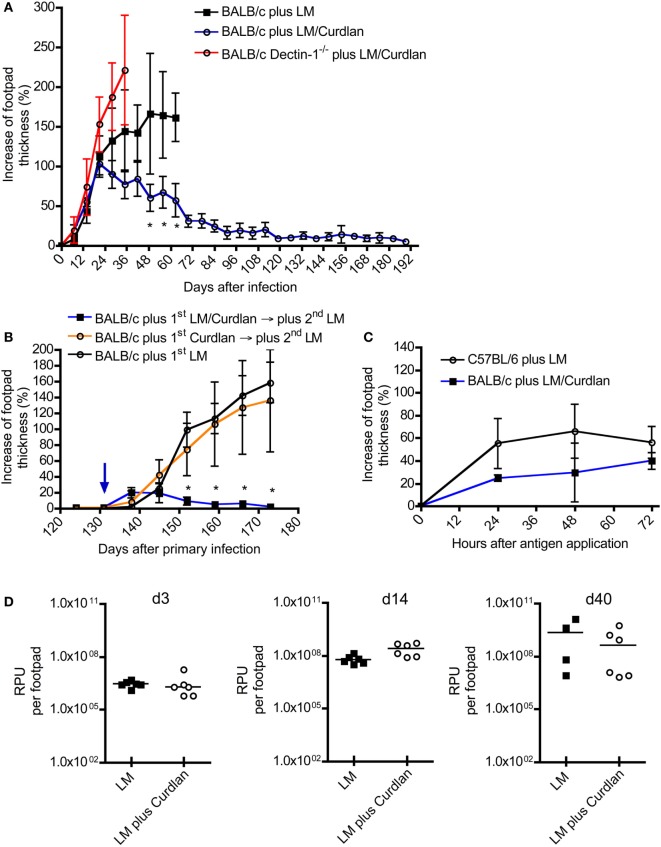
The presence of Curdlan at the site of infection results in an adaptive immune response in normally susceptible BALB/c. (A) BALB/c control mice were infected intradermally with Leishmania (L.) major into the right footpad (black line, black squares; 3 × 106 parasites/30 μL; n = 19), abbreviated as BALB/c plus LM. Another group of BALB/c mice was infected with 30 µL of mixture of 3 × 106 parasites and Curdlan (c = 50 μg/μL, blue line, black circles; n = 16), abbreviated as BALB/c plus LM/Curdlan. BALB/c mice deficient for Dectin-1 were also infected with 30 µL of a mixture of 3 × 106 parasites and Curdlan (c = 50 µg/µL, red line, black circles; n = 5), abbreviated as BALB/c Dectin-1−/− plus LM/Curdlan. Based on severe necrosis of the infected footpads, the groups BALB/c plus LM and BALB/c Dectin-1−/− plus LM/Curdlan had to be terminated at days 60 and 36, respectively. The y-axis depicts the increase in footpad thickness (mean ± SD). Data were analyzed using Student’s t-test and highlighted if differences are significant (*p < 0.05; BALB/c plus LM compared to BALB/c plus LM/Curdlan). (B) Resistant BALB/c mice that had been treated with Curdlan in the presence of L. major parasites were reinfected at day 131 (blue arrow) after primary infection (abbreviated as BALB/c plus 1st LM/Curdlan → 2nd LM, blue line, black squares; n = 3). BALB/c mice that had been treated with Curdlan alone 131 days before (abbreviated as BALB/c plus 1st Curdlan → 2nd LM, orange line, black circles; n = 3) were also infected. Naïve BALB/c mice were infected (BALB/c plus 1st LM, black line, black circle; n = 5), too. The y-axis depicts the increase in footpad thickness (mean ± SD). Data (BALB/c plus 1st LM compared to BALB/c plus 1st LM/Curdlan → 2nd LM) were analyzed using two-way ANOVA (*p < 0.05). (C) A delayed-type hypersensitivity (DTH) response is shown, comparing C57BL/6 mice infected with 3 × 106 parasites (plus LM, black line, black circles; n = 3) with BALB/c mice infected with 3 × 106 parasites plus Curdlan (plus LM/Curdlan, blue line, black squares; n = 3). The DTH response was induced 217 days after primary infection as described in Section “Materials and Methods.” The y-axis depicts the increase in footpad thickness (mean ± SD), the x-axis hours after antigen application. (D) Relative parasite units (RPU) representing the relative amount of parasites per footpad at days 3, 14, and 40 after infection are displayed. Infected BALB/c mice (LM, black squares) were compared with BALB/c mice that had been infected with parasites plus Curdlan (LM plus Curdlan, black circles). The mean (horizontal line) is shown. Each circle or square represents one analyzed footpad. Data were analyzed using Student’s t-test (d3 p = 0.779, d14 p = 0.062, and d40 p = 0.286).